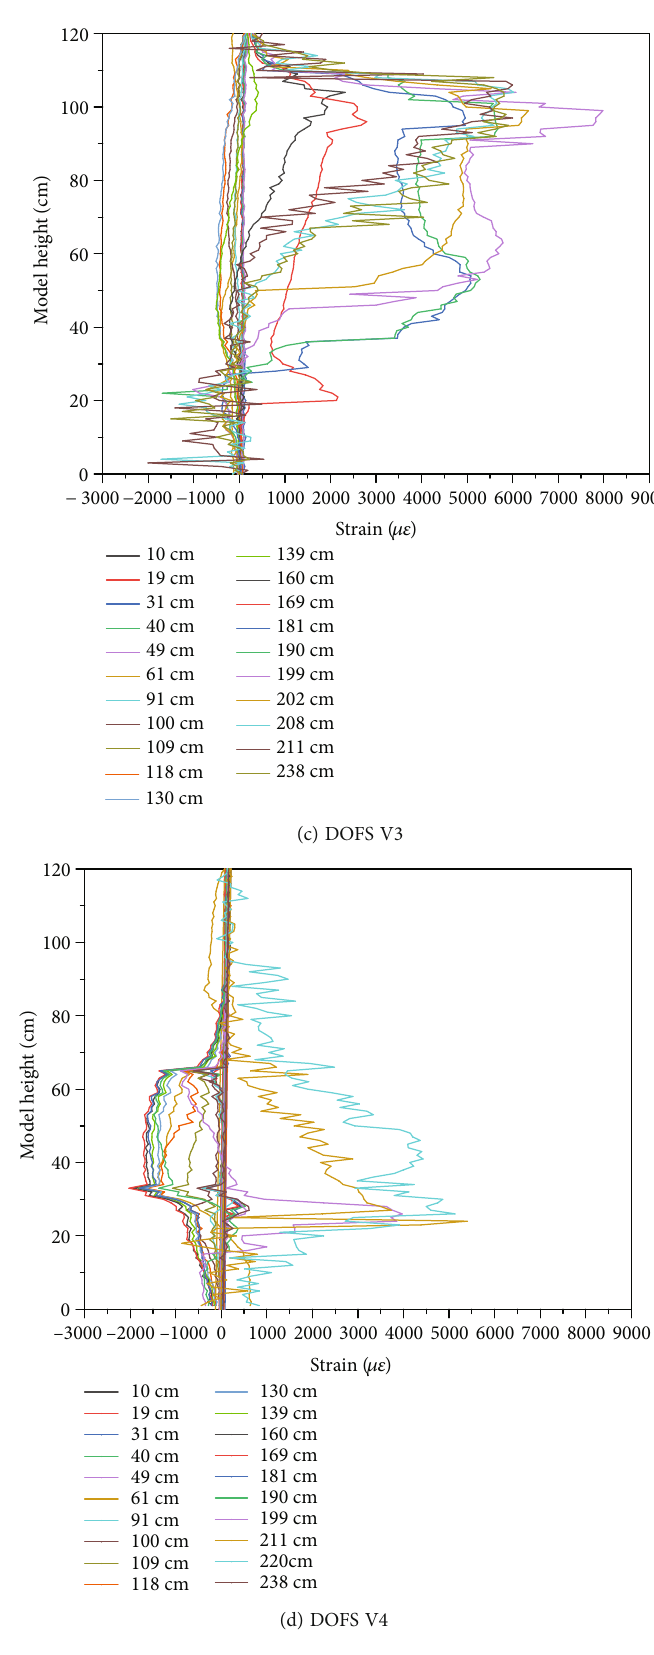
Figure 4: Strain monitoring results of DOFSs V1-V4 in the mining of coal seam 2 -2